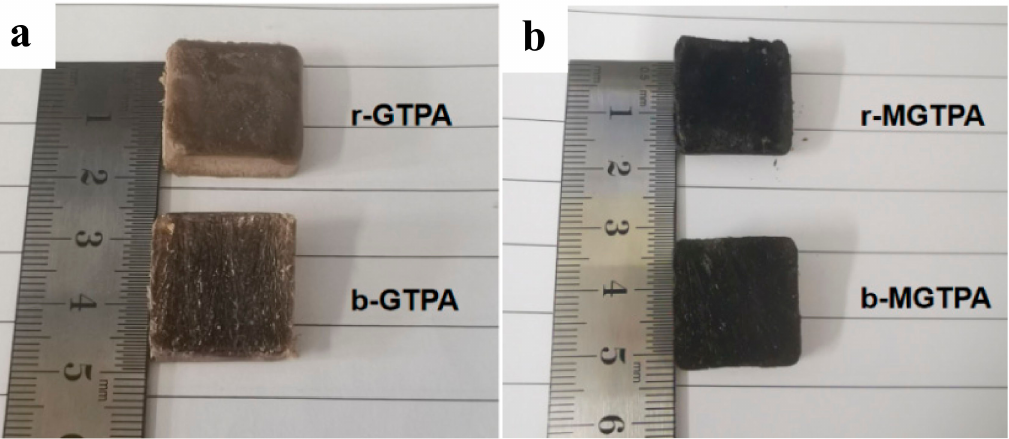
Figure 4. ( a ) Photograph of r-GTPA and b-GTPA. ( b ) Photograph of r-MGTPA and